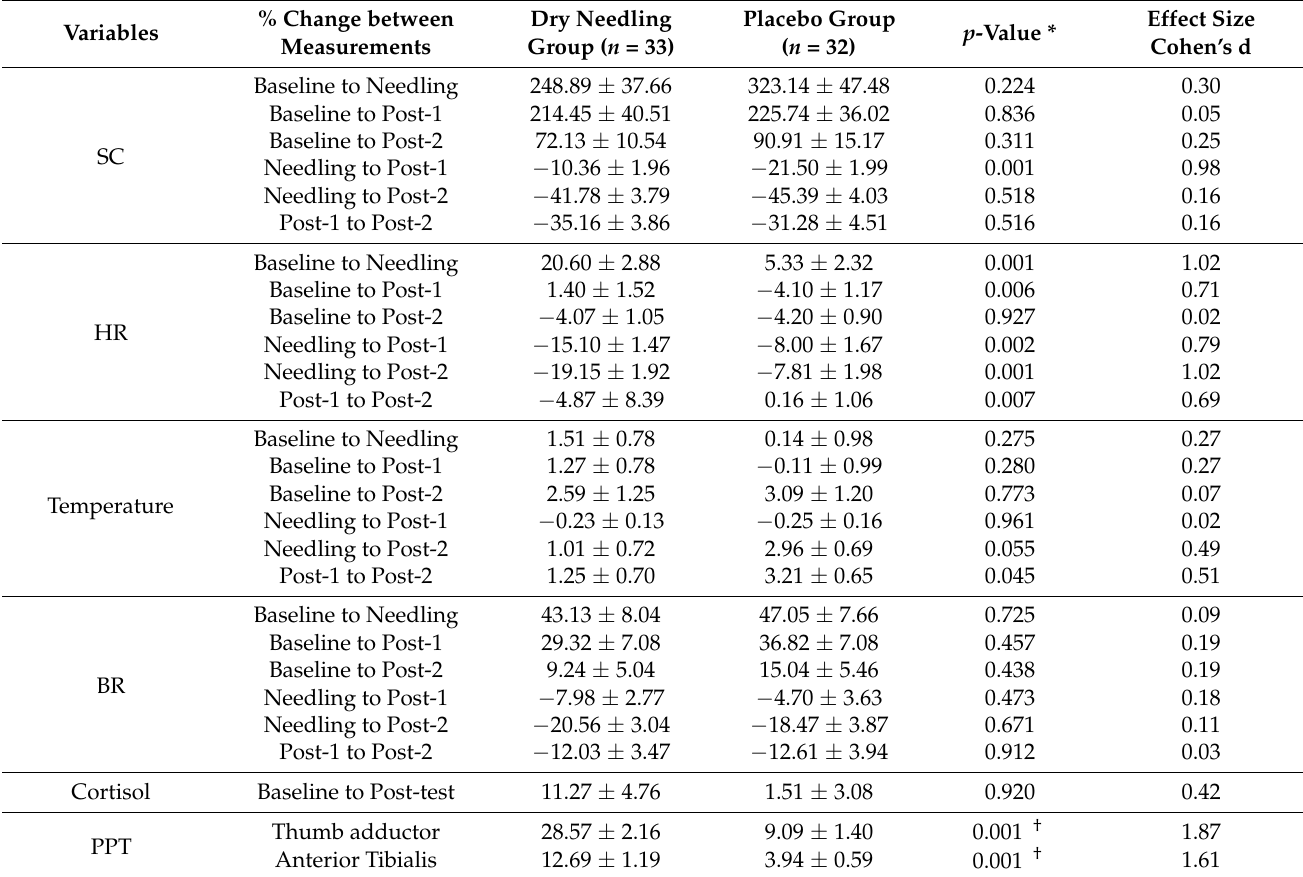
Table 3. % Change in primary outcomes and pressure pain